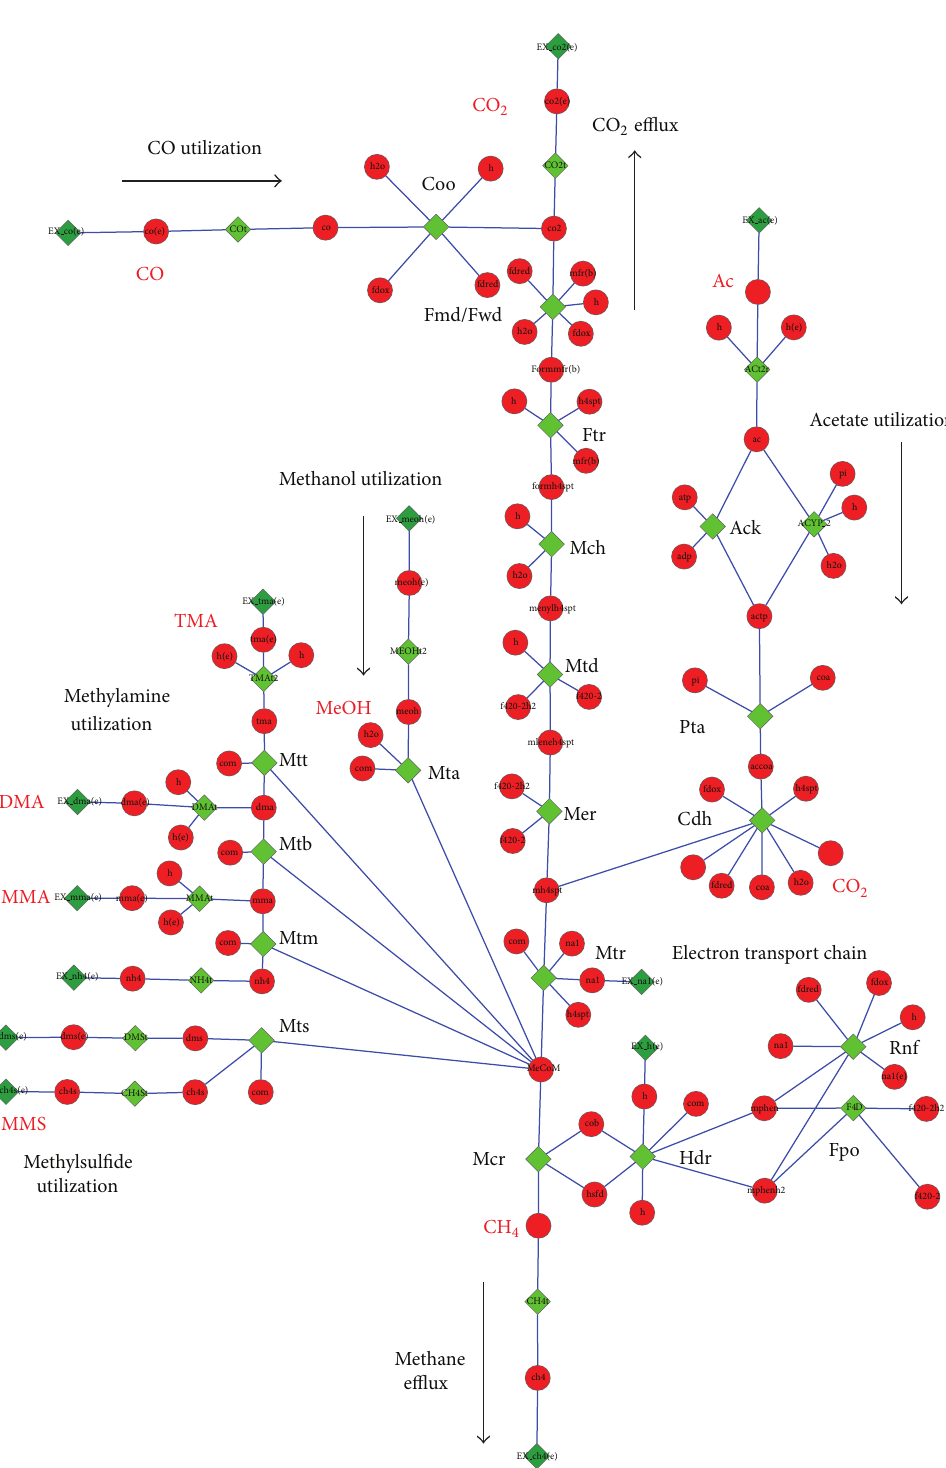
Figure 4: Methanogenesis pathways in metabolic map of M. acetivorans [22]. Enzymes and metabolites are depicted as nodes while reactions are depicted as edges between these nodes. Enzymes that catalyse reactions are shown as green diamonds and metabolites are shown as red circles. Enzyme names are in black and select metabolite names are in